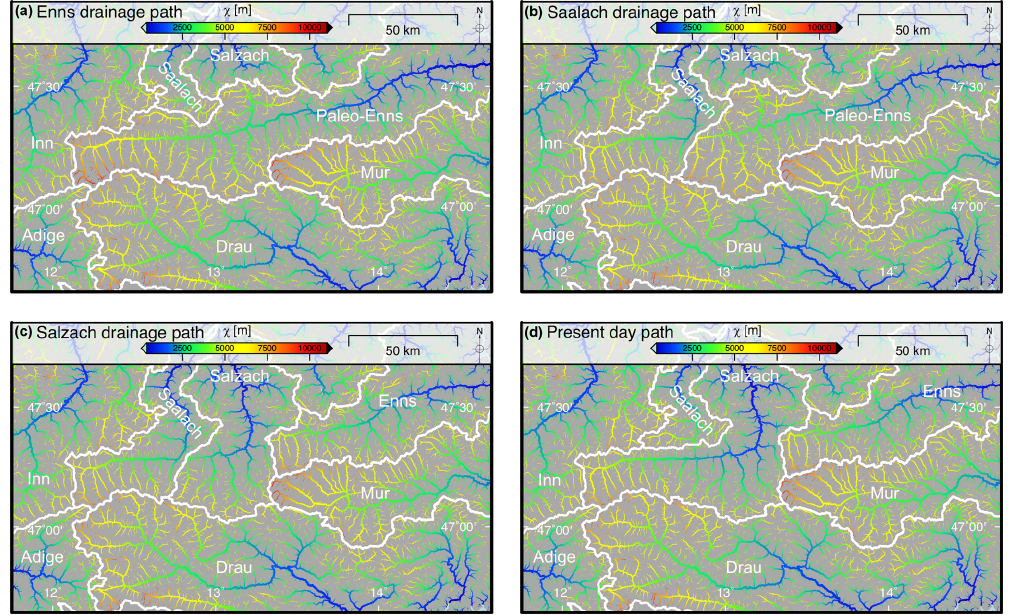
Figure 7. The χ -coloured drainage pattern of reconstructed paleo-drainage geometries of the Eastern Alps. All streams with a contributing drainage area larger than 1km 2 are shown, and the line width of the channels is proportional to log 10 (drainage area). The base level for χ computation is set to 400m. White lines and annotations represent the major drainage divides. (a) Enns drainage path–drainage scenario assuming an elongated Enns catchment representing the mid-Miocene situation as suggested by Frisch et al. (1998). (b) Saalach drainage path–drainage scenario assuming that the Saalach captured the westernmost part of the Paleo-Enns catchment. (c) Salzach drainage path– drainage scenario assuming that both the Saalach and Salzach took over parts of the Paleo-Enns catchment as suggested by Robl et al. (2008a). (d) Present-day drainage pattern for